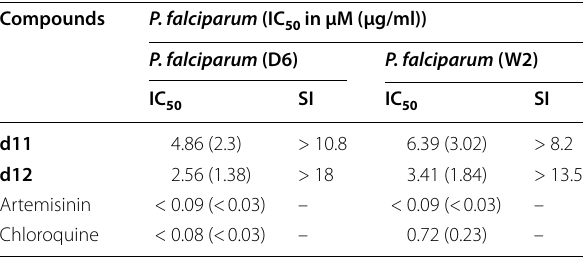
Table 36 In vitro antimalarial activity of N -aryl and heteroaryl sulfonamide derivatives Compounds